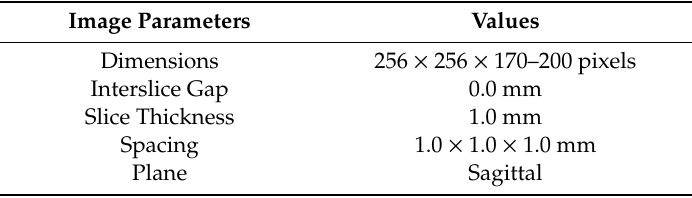
Figure 1. Sample images extracted from the PPMI repository. ( a ) MRI scan of a subject belonging to the control group. ( b ) MRI scan of a subject belonging to the prodromal group. ( c ) MRI scan of a subject belonging to the Parkinson’s disease group. Table 3. Specification of the acquired scans from